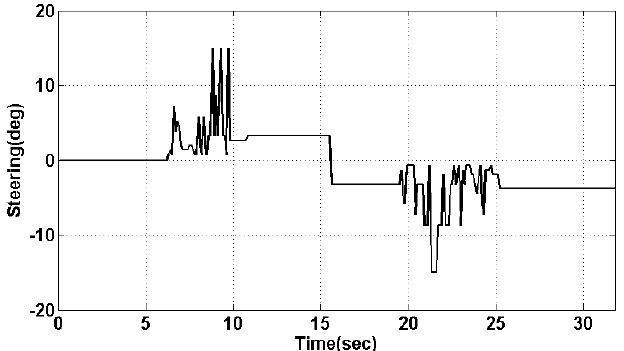
Figure 26. Steering angle output generated by the Fuzzy steering controller designed in [24] based on the estimated lateral misalignment shown in Figure 22.